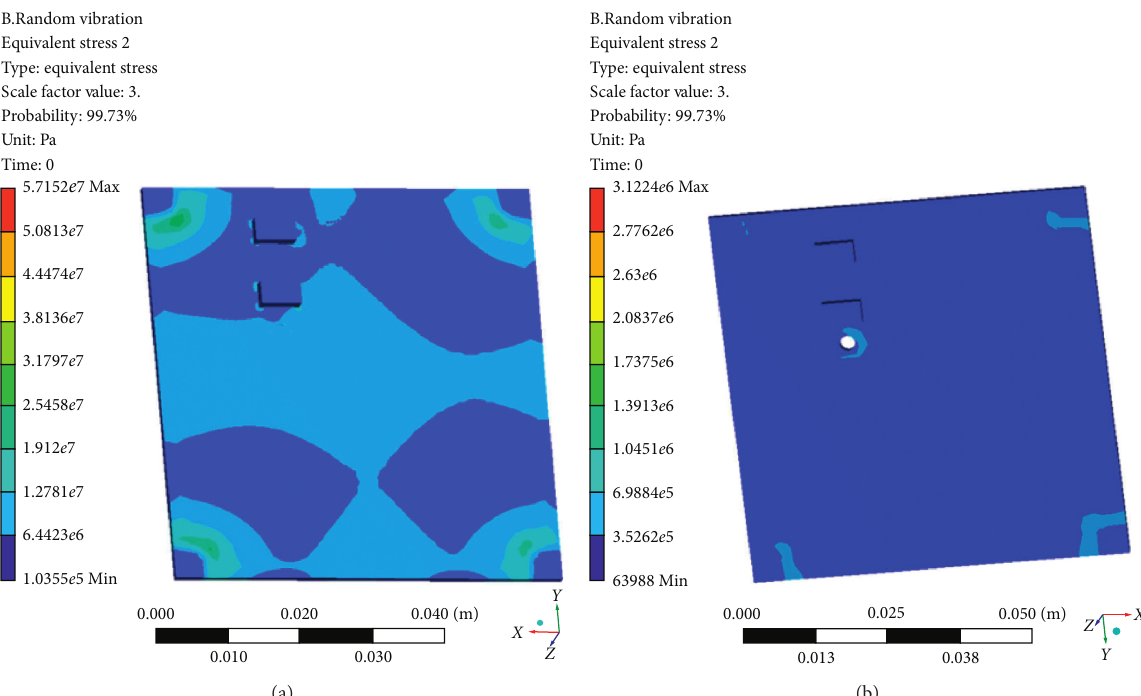
Figure 17: Comparative analysis of stress simulation at the welding point of the semiconductor tube (a) before optimization and (b) after